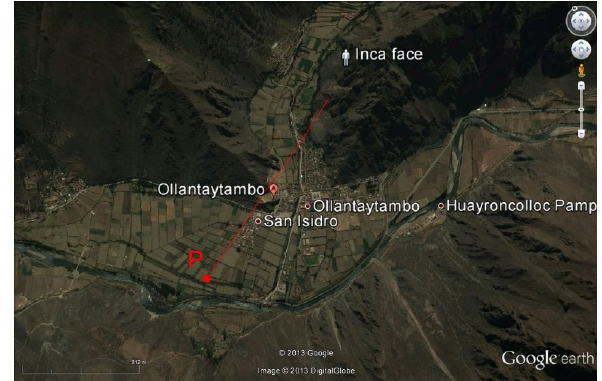
Figure 8: The line connecting pyramid, Temple of the Sun and